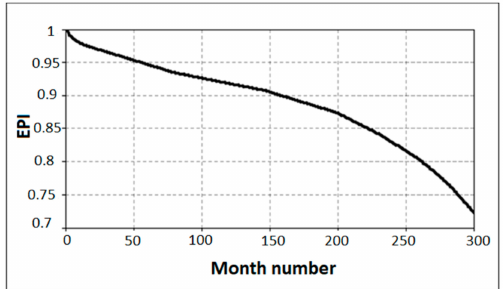
Figure 6. Environmental Performance Index (EPI) variation over the water distribution network (WDN) operation time